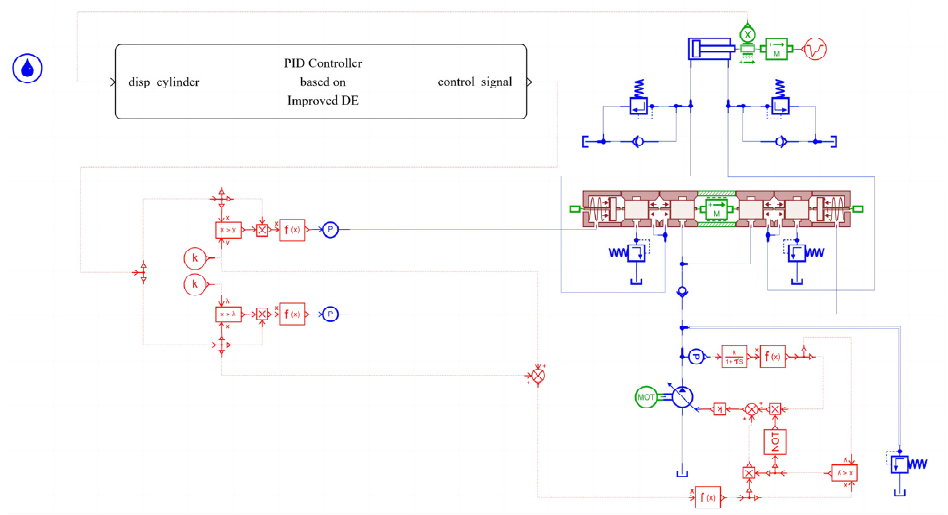
Figure 9. Co-simulation model of bucket